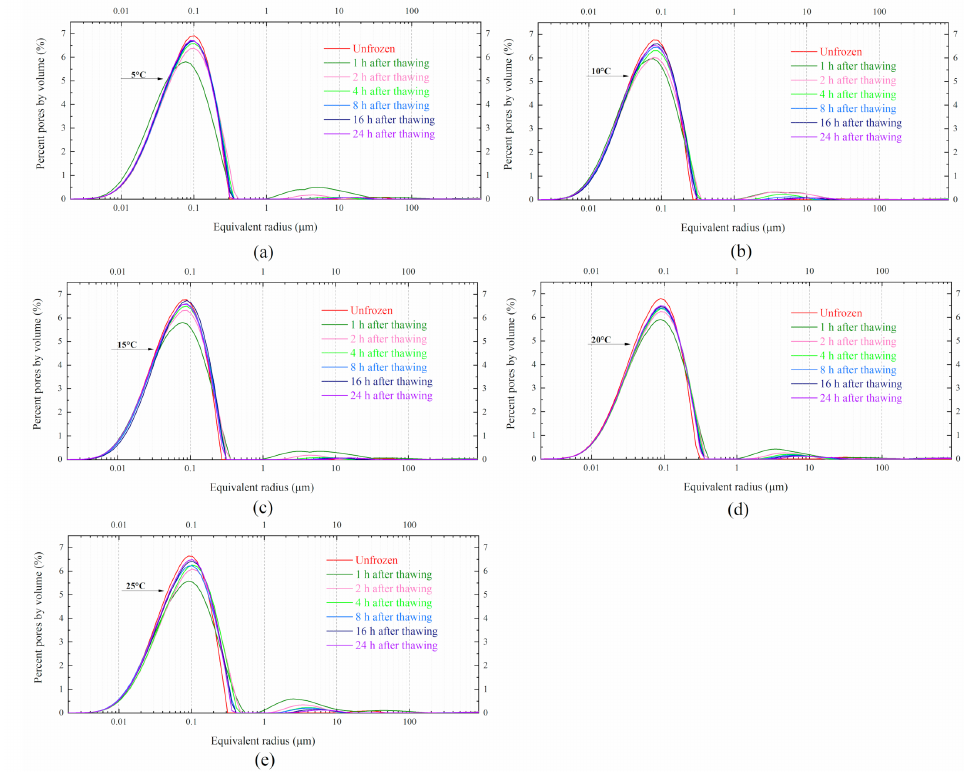
Figure 13. PSD at different thawing temperature: ( a – e ) show the PSDs at 5, 10, 15, 20, and 25 ◦ C,